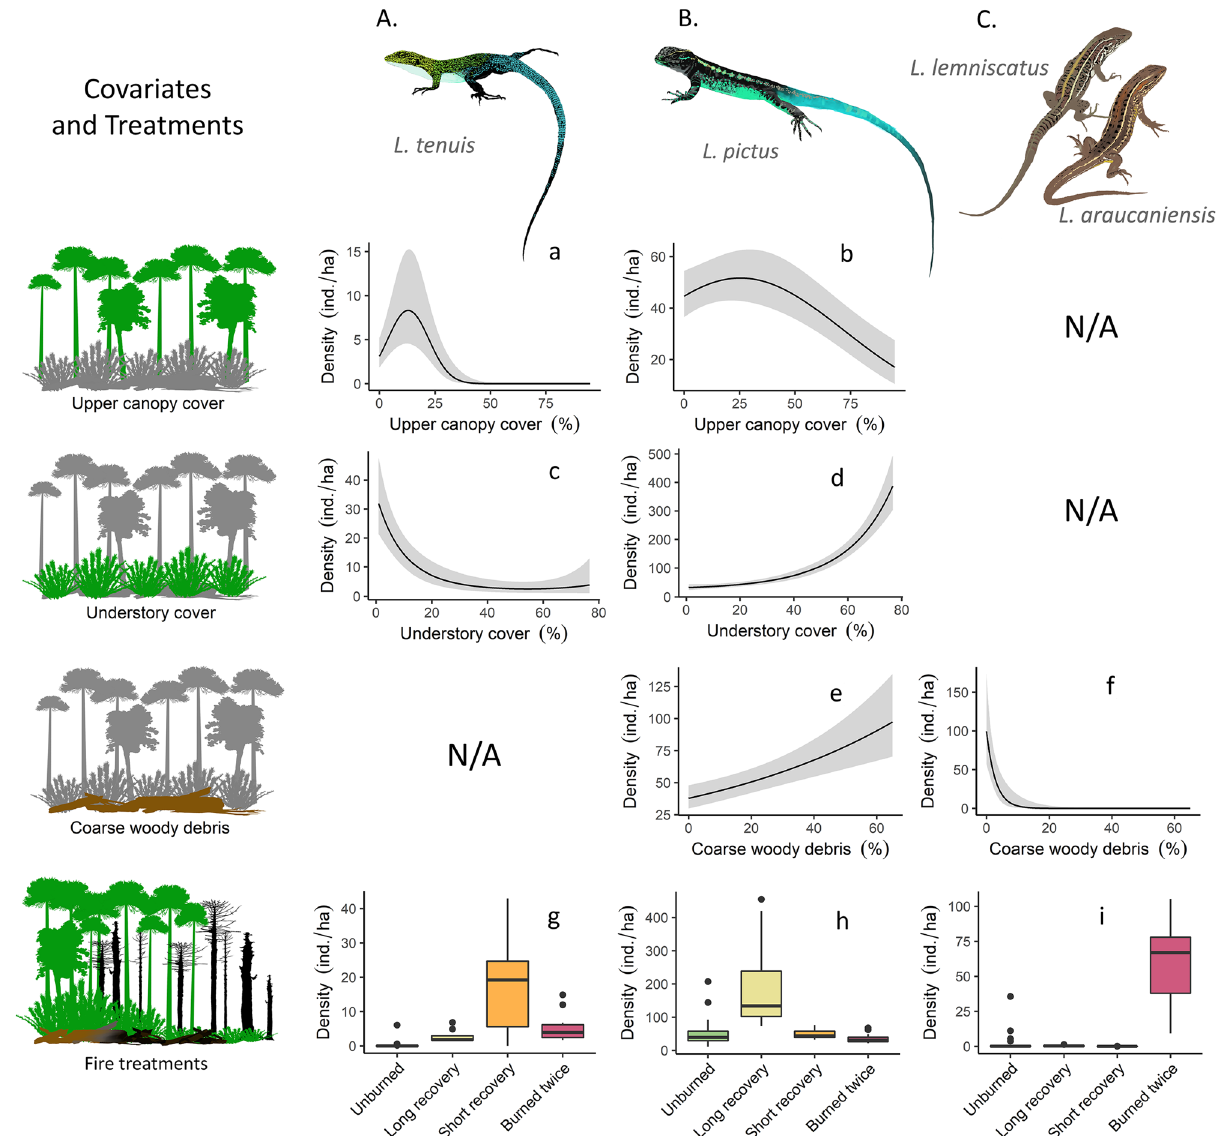
to bottom: upper canopy cover, understory cover, coarse woody debris cover, and fire treatments). Graphics are ordered by columns according to each modeled species: ( A ) slender lizard ( L. tenuis ); ( B ) painted lizard ( L. pictus ); and ( C ) araucana and ribboned lizards (“ground lizards”, L. araucaniensis and L. lemniscatus , respectively). Grey area shows estimated 95% confidence intervals. N/A (not applicable) indicate uninformative covariates according to AIC results for each species’